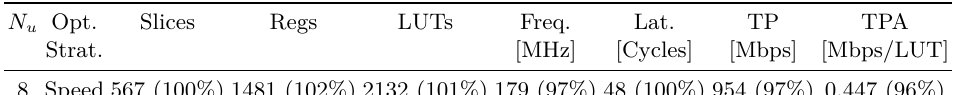
Table 18: Spook v2 : Artix-7 implementations results (post place-and-route). The percent- ages are the comparison with the Spook v1 corresponding metrics. N u Opt. Slices Regs LUTs Freq. Lat. TP TPA Strat. [MHz] [Cycles] [Mbps] [Mbps/LUT]